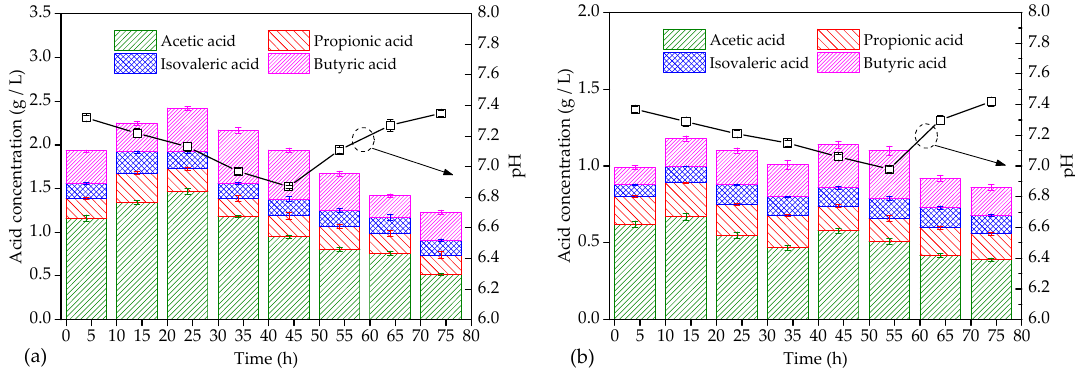
Figure 10. VFAs distribution and the pH during acidogenic fermentation with the hydrolyzate. ( a ) 1 × 10 − 5 mol / L FeCl 2 (bottle 1 # ); ( b ) distilled water (bottle 2 # ).